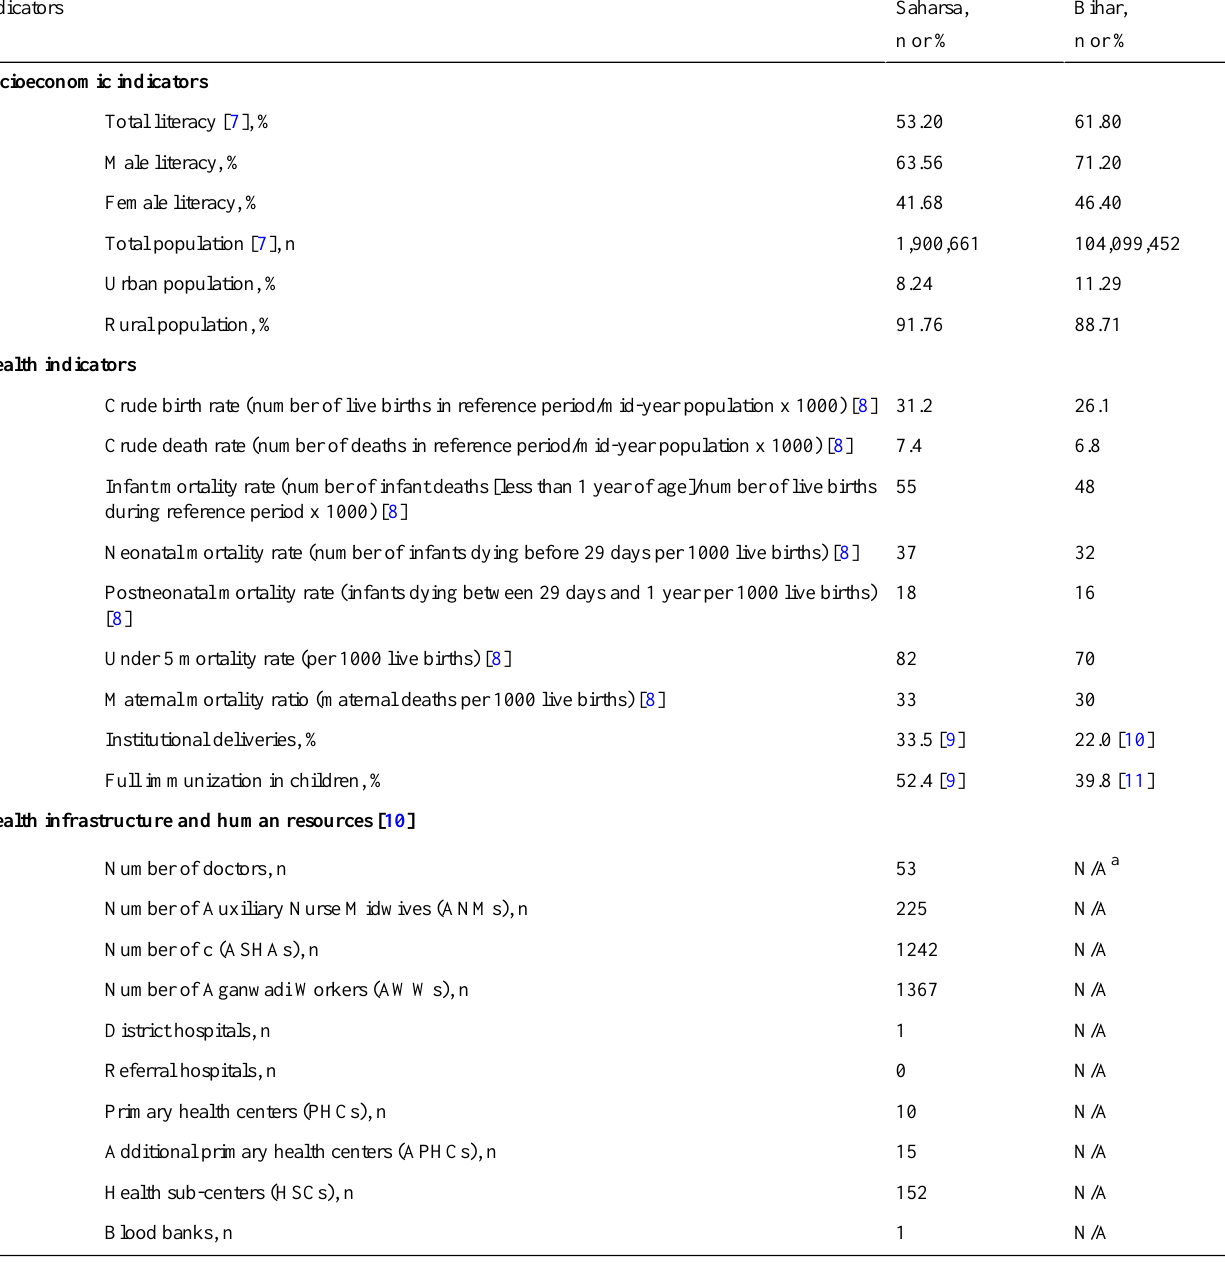
Table 1. Socioeconomic, health, and health infrastructure indicators for Saharsa and Bihar.